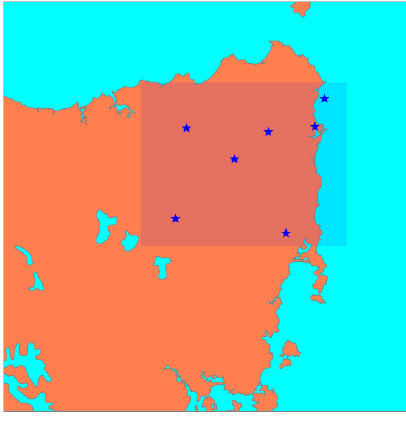
Figure 4. The stars indicate the optimum placement of seven sensor nodes suggested by the proposed method. The South Esk (Region of Interest in this study) is indicated by the rectangular region.